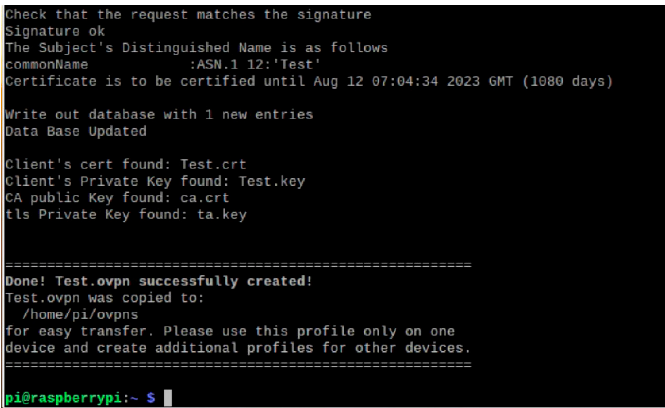
Figure 6. Creation of a VPN certificate using the Secure Socket Layer (SSL) security protocol.